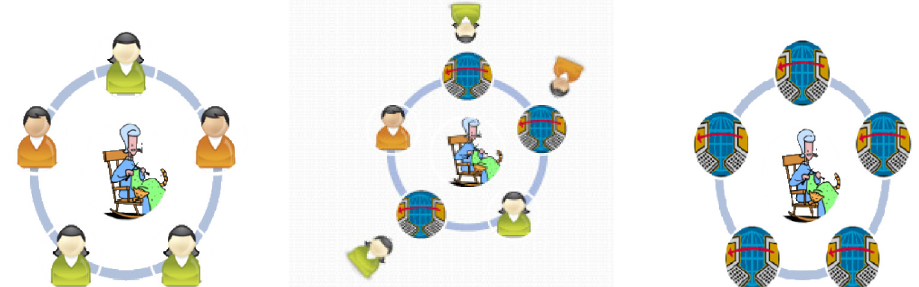
Figure 5. Potential deterioration of human circle of